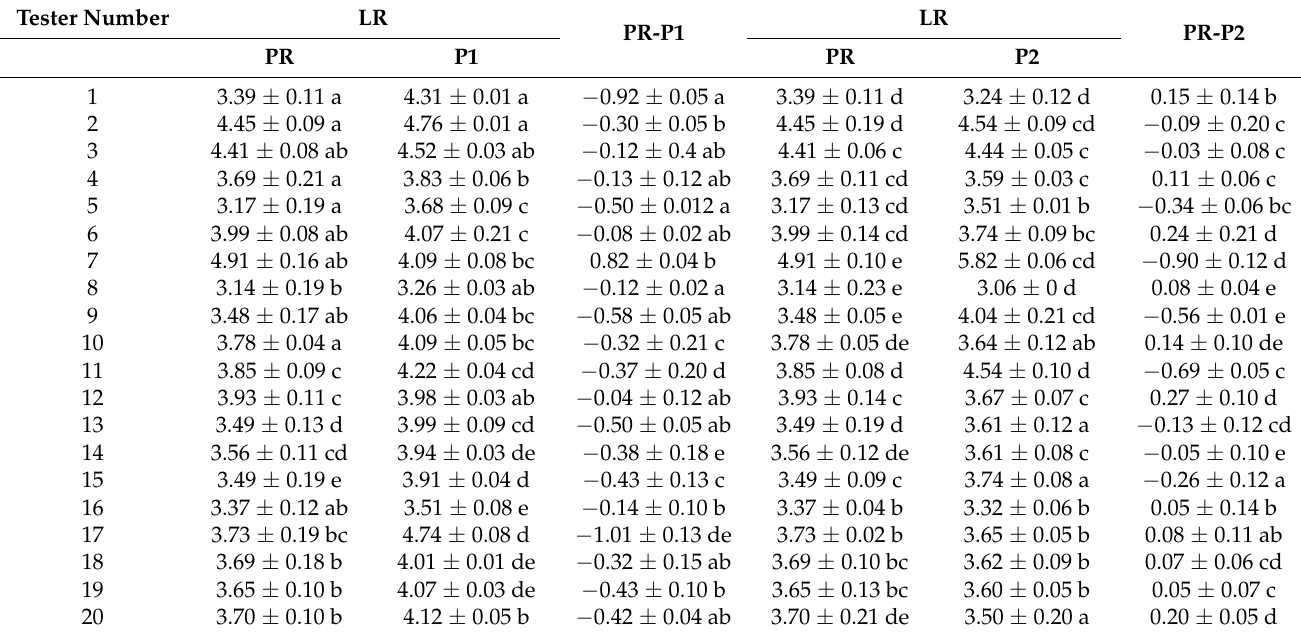
Table 5. Statistical analysis of plant preparations P1 and P2 and the reference preparation (PR) according to EN 1500:2013 against Escherichia coli K12 strain NCTC